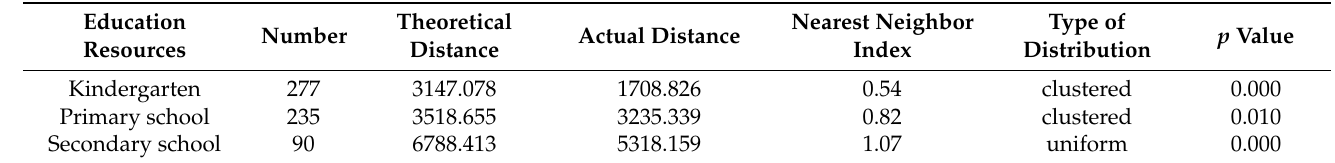
Table 2. The nearest neighbor index and its spatial distribution types of rural basic education resources in Wuhan City’s new urban districts.